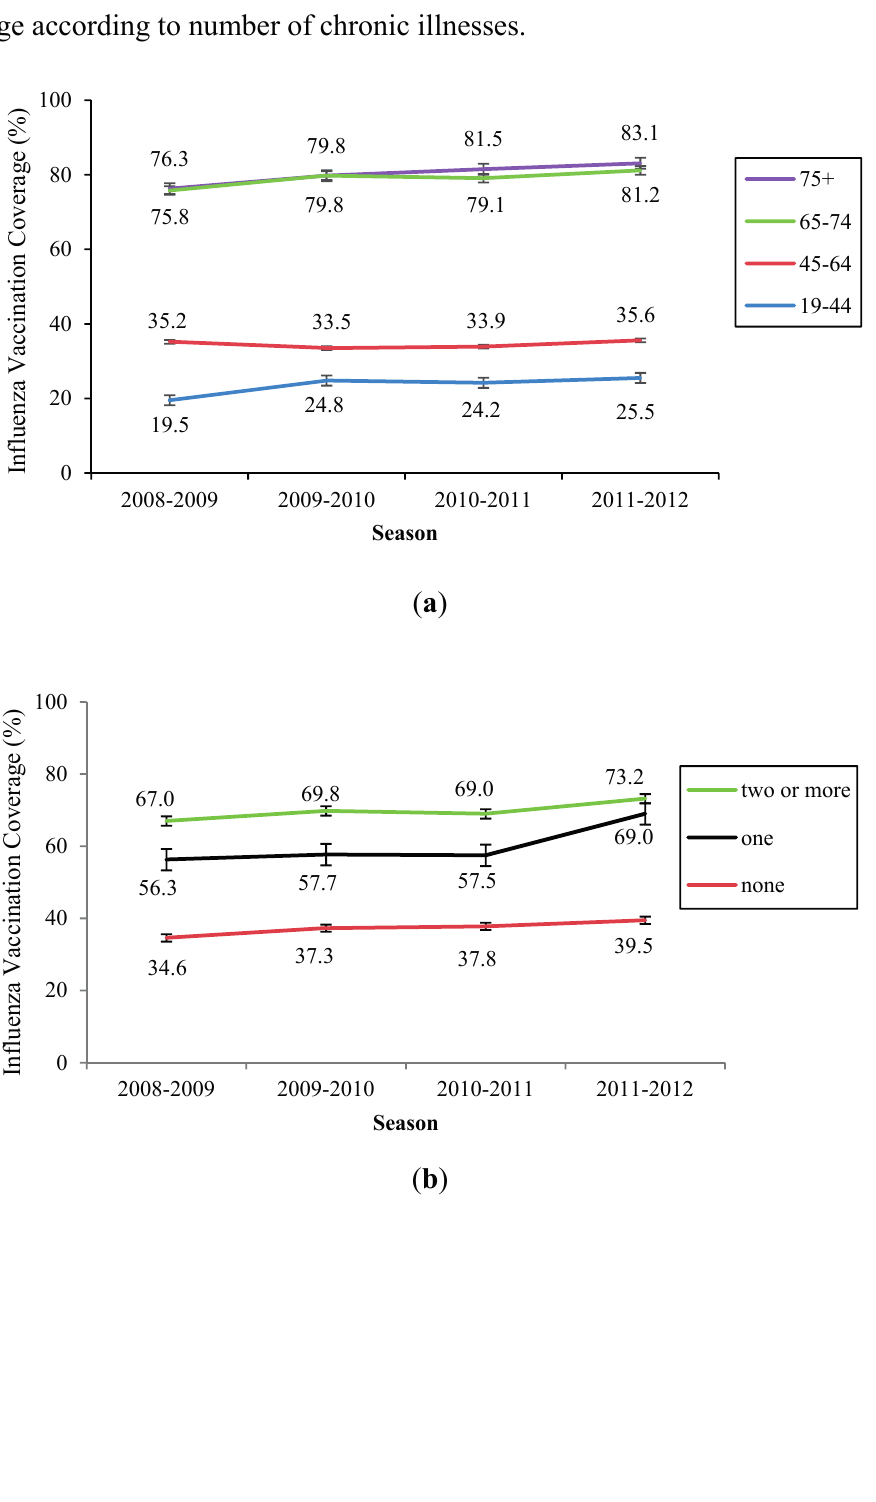
Figure 1. ( a ) Influenza vaccination coverage by age group; ( b ) Influenza vaccination coverage according to number of chronic